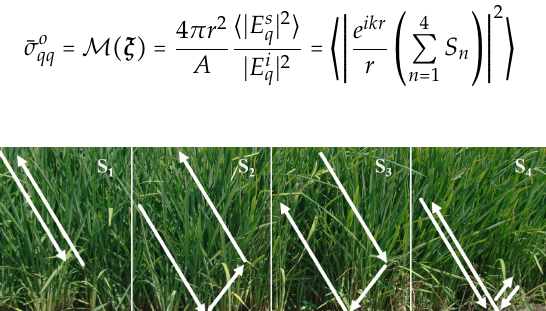
The four different scattering mechanisms considered within the EM model [11]. S 1 : Direct scattering from the scatterers, S 2 : Scattering from the canopy followed by reflection from the ground, S 3 : Reflection from the ground followed by scattering from the canopy, S 4 : Reflection from the ground followed by scattering from the canopy and followed by reflection from the